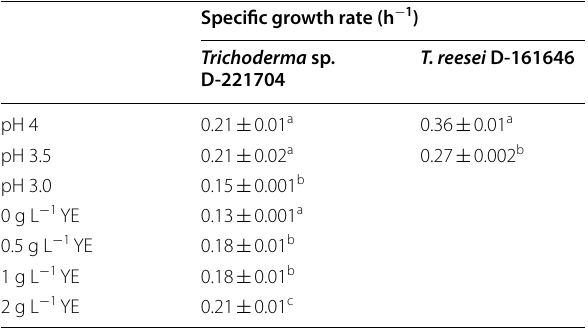
Values in the same column and category (either pH or yeast extract, YE, concentration) with the same superscript letter (a, b or c) did not differ significantly (p >